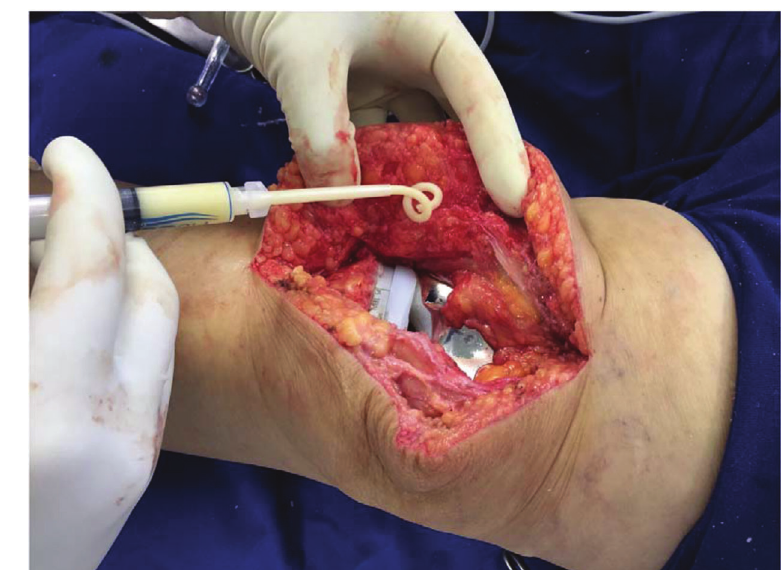
Figure 1 - Application of Floseal s to the surgical